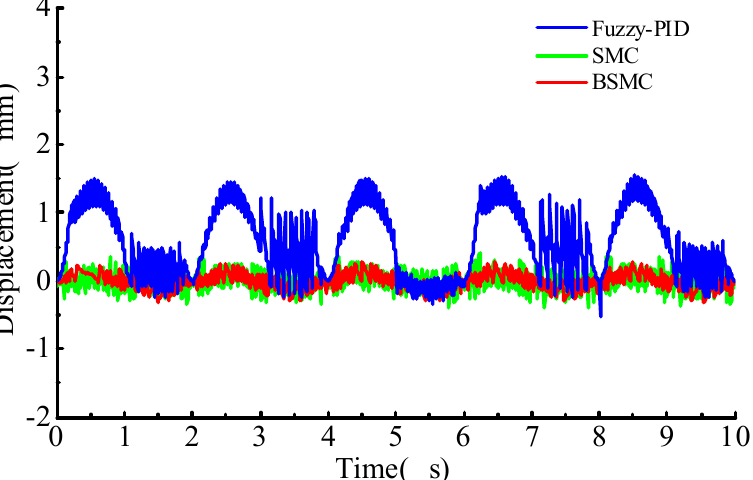
Figure 10. Tracking error of sinusoidal response of the cylinder under random load. Figure 11 shows the velocity change of the hydraulic cylinder under sinusoidal instruc- tions with a random load. It can be seen that the fluctuation range of the cylinder speed with conventional sliding-mode control is smaller than that with fuzzy-PID, although both are larger than that with backstepping sliding-mode control. The cylinder speed with the three control algorithms is illustrated in Figure 11. The system adopting the fuzzy PID has the largest fluctuation amplitude of the tracking error, Comparatively, the backstep- ping sliding-mode control allows the system with the lowest fluctuation amplitude of the tracking